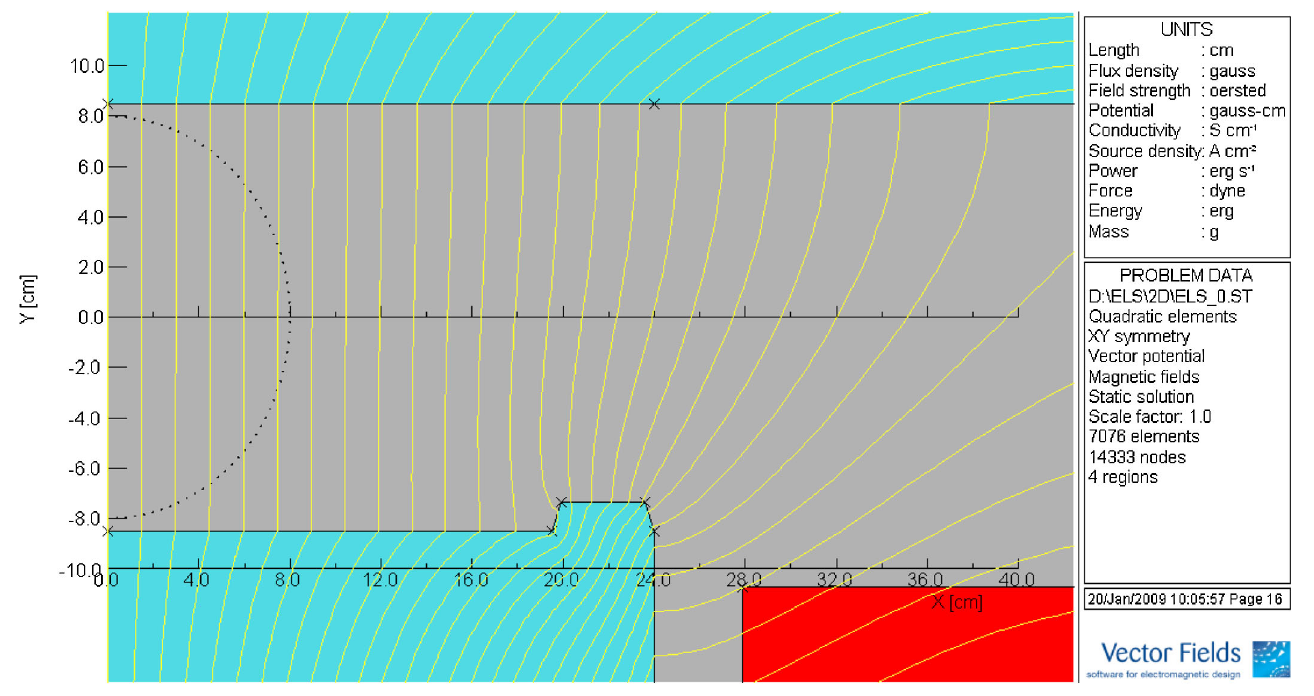
FIG. 12. (Color) The central area of a 2D ELS